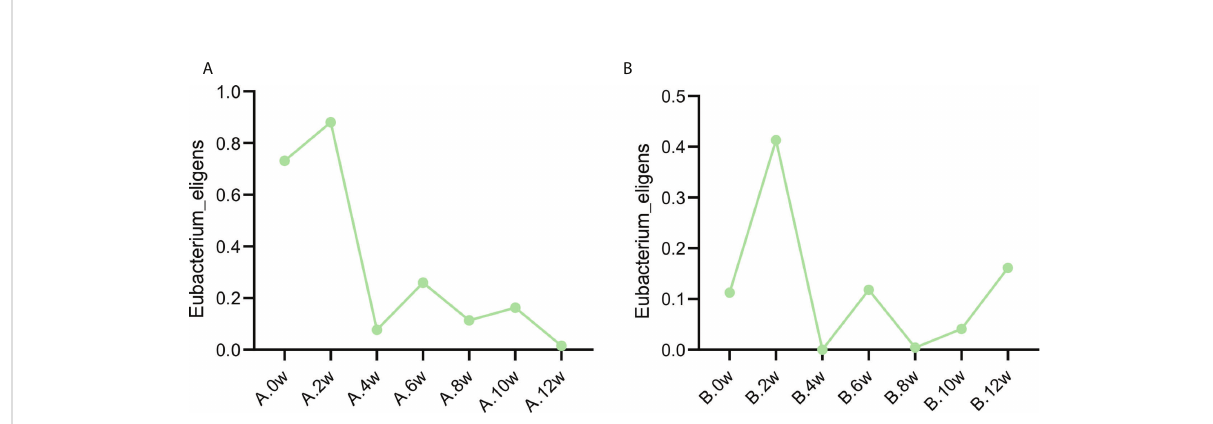
FIGURE 5 Variation trend of Eubacterium eligens before and after different treatment. (A) Case 1, (B) Case